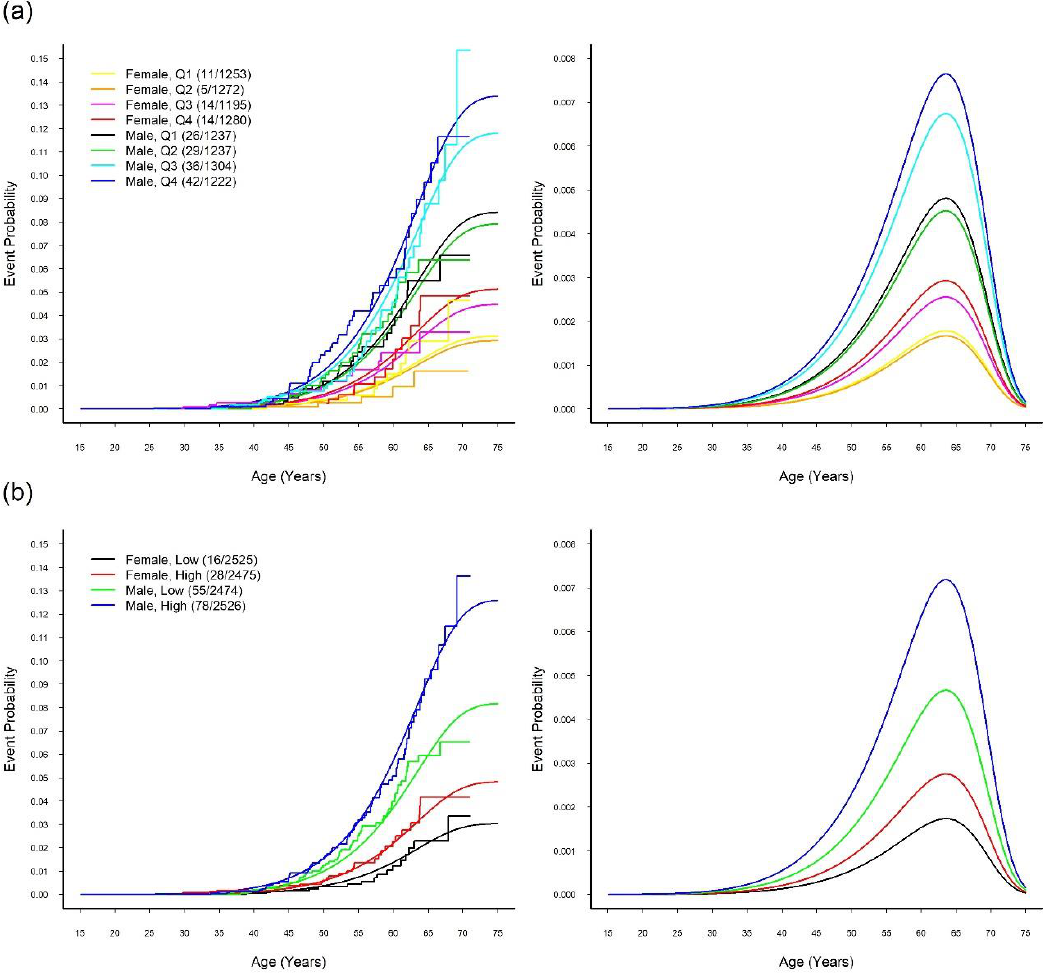
Figure 3. Time-to-event curves and probability density curves of CVD event. Smooth and step event time curves (left panel) and probability density curves (right panel) estimated from the optimally fitted logistic-GGD location – scale mixture regression models of the CVD disease stratified by ( a ) sex and four SUA-WGRS groups and ( b ) sex and two SUA-WGRS groups.